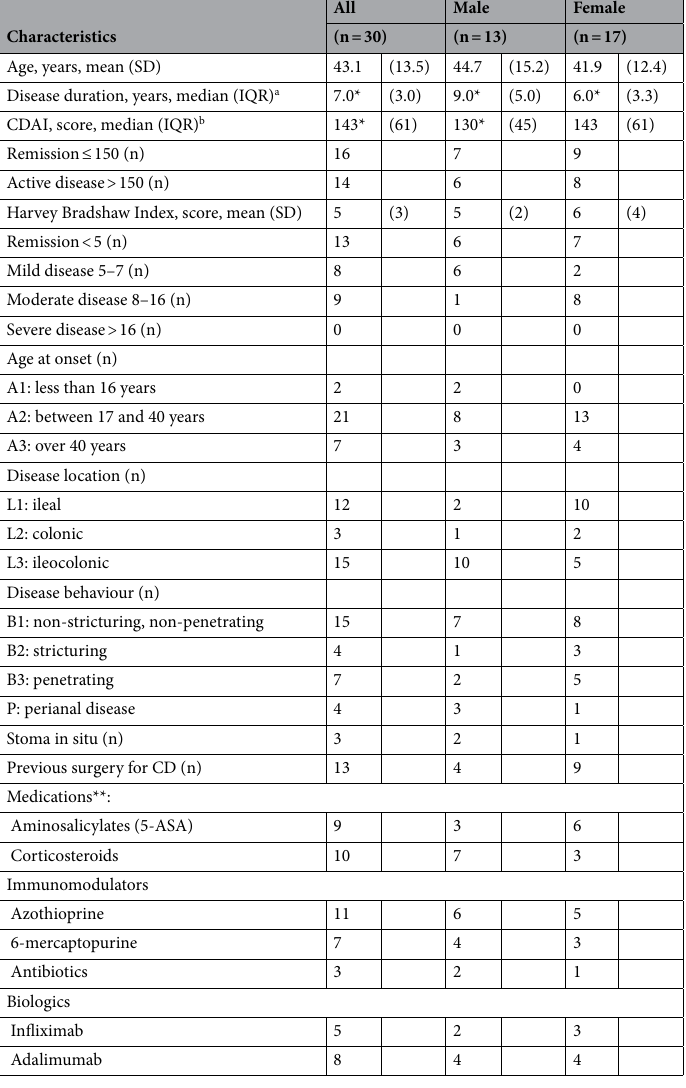
Table 1. Clinical details of participants including gender, age, disease activity, disease location and disease behaviour. CDAI, Crohn’s disease Activity Index. a n = 29 with information on years of diagnosis; b n = 29 with CDAI; *not normally distributed (Shapiro–Wilk p < 0.05); **There was no observed association between medical treatment and either physical activity levels or fat